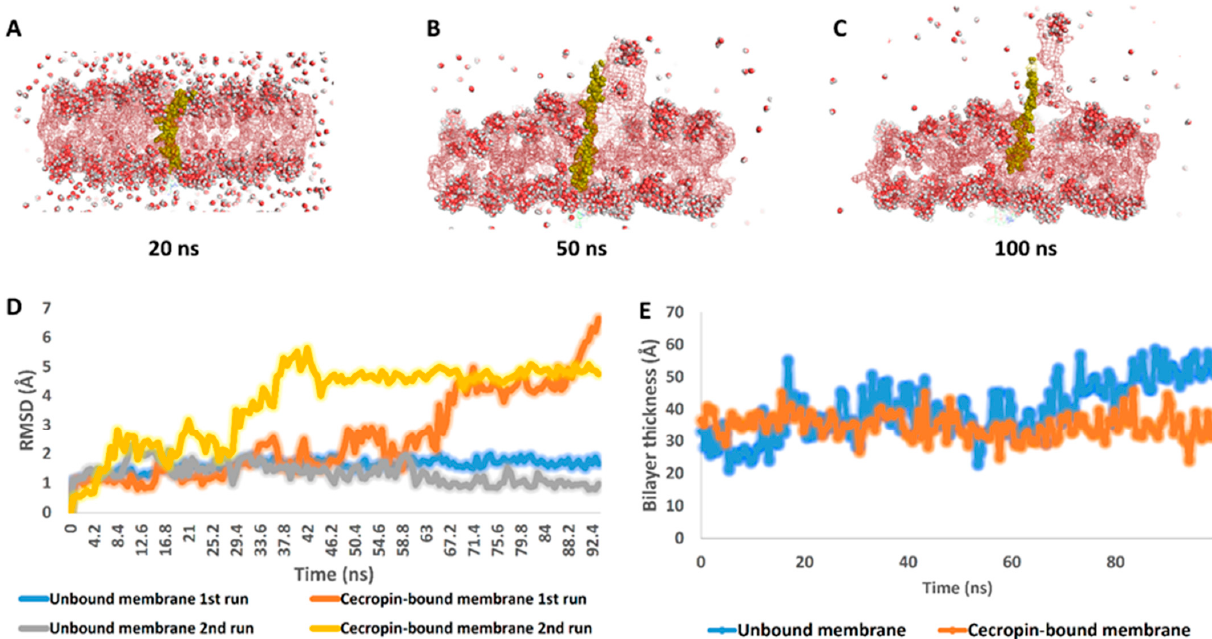
Figure 2. Snapshots extracted from the 100 ns-long simulation at 20 ns, 50 ns, and 100 ns ( A – C ). ( D ) Root Mean Square Deviations (RMSDs) of the bilayer system (CecA-bound and unbound) over two runs of 100 ns-long molecular dynamics simulations. ( E ) The average of the bilayer thickness changed (CecA-bound and unbound) over two runs of 100 ns-long MDS runs. The supplemen- tary video can be found here: https://zenodo.org/record/7058606#.YzNGQHbP2M8, accessed on 28 August